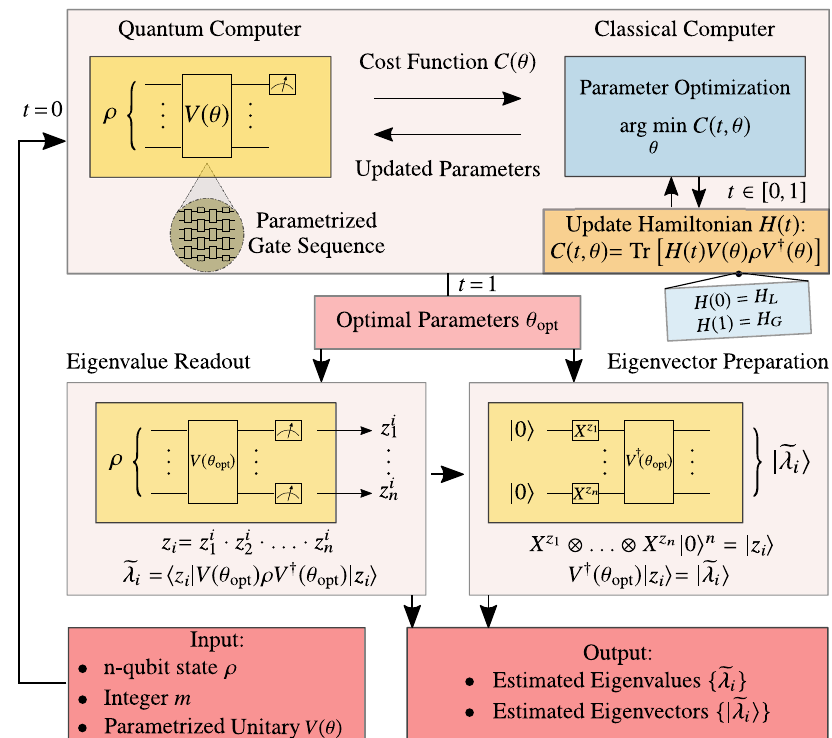
Fig. 1 Schematic diagram of VQSE. VQSE takes as inputs an n -qubit state ρ , an integer m , and a parametrized unitary V ( θ ). It then outputs estimates of the m -largest eigenvalues of ρ , and their associated eigenvectors. The fi rst step of the algorithm is a hybrid quantum-classical optimization loop to train the parameters θ , and minimize the cost function de fi ned in (4) as the expectation value of a Hamiltonian H ( t ) over the state ~ ρ ¼ V ð θ Þ ρ V y ð θ Þ . To facilitate this optimization, we adaptively update H ( t ) using information obtained via measurements on ~ ρ . When this optimization terminates, at which point we say θ = θ opt , one reads off the eigenvalues. Namely, by preparing V ( θ opt ) ρ V † ( θ opt ) and measuring in the standard basis, one obtains bitstrings z whose associated frequencies are estimates of the eigenvalues of ρ . Finally, one prepares the estimated eigenvectors by preparing the states z j i and acting on them with V † ( θ opt